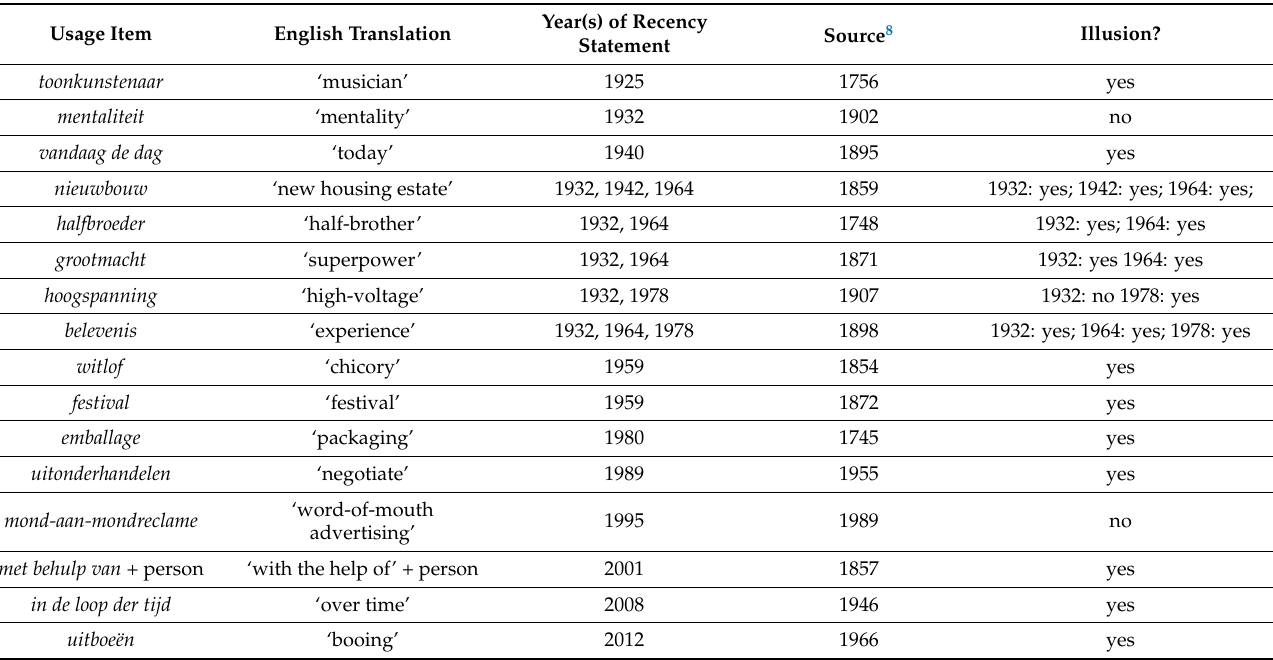
Table 6. Lexical usage items with year(s) of prescriptive utterance, earliest occurrence in usage, and evaluation with regard to Recency